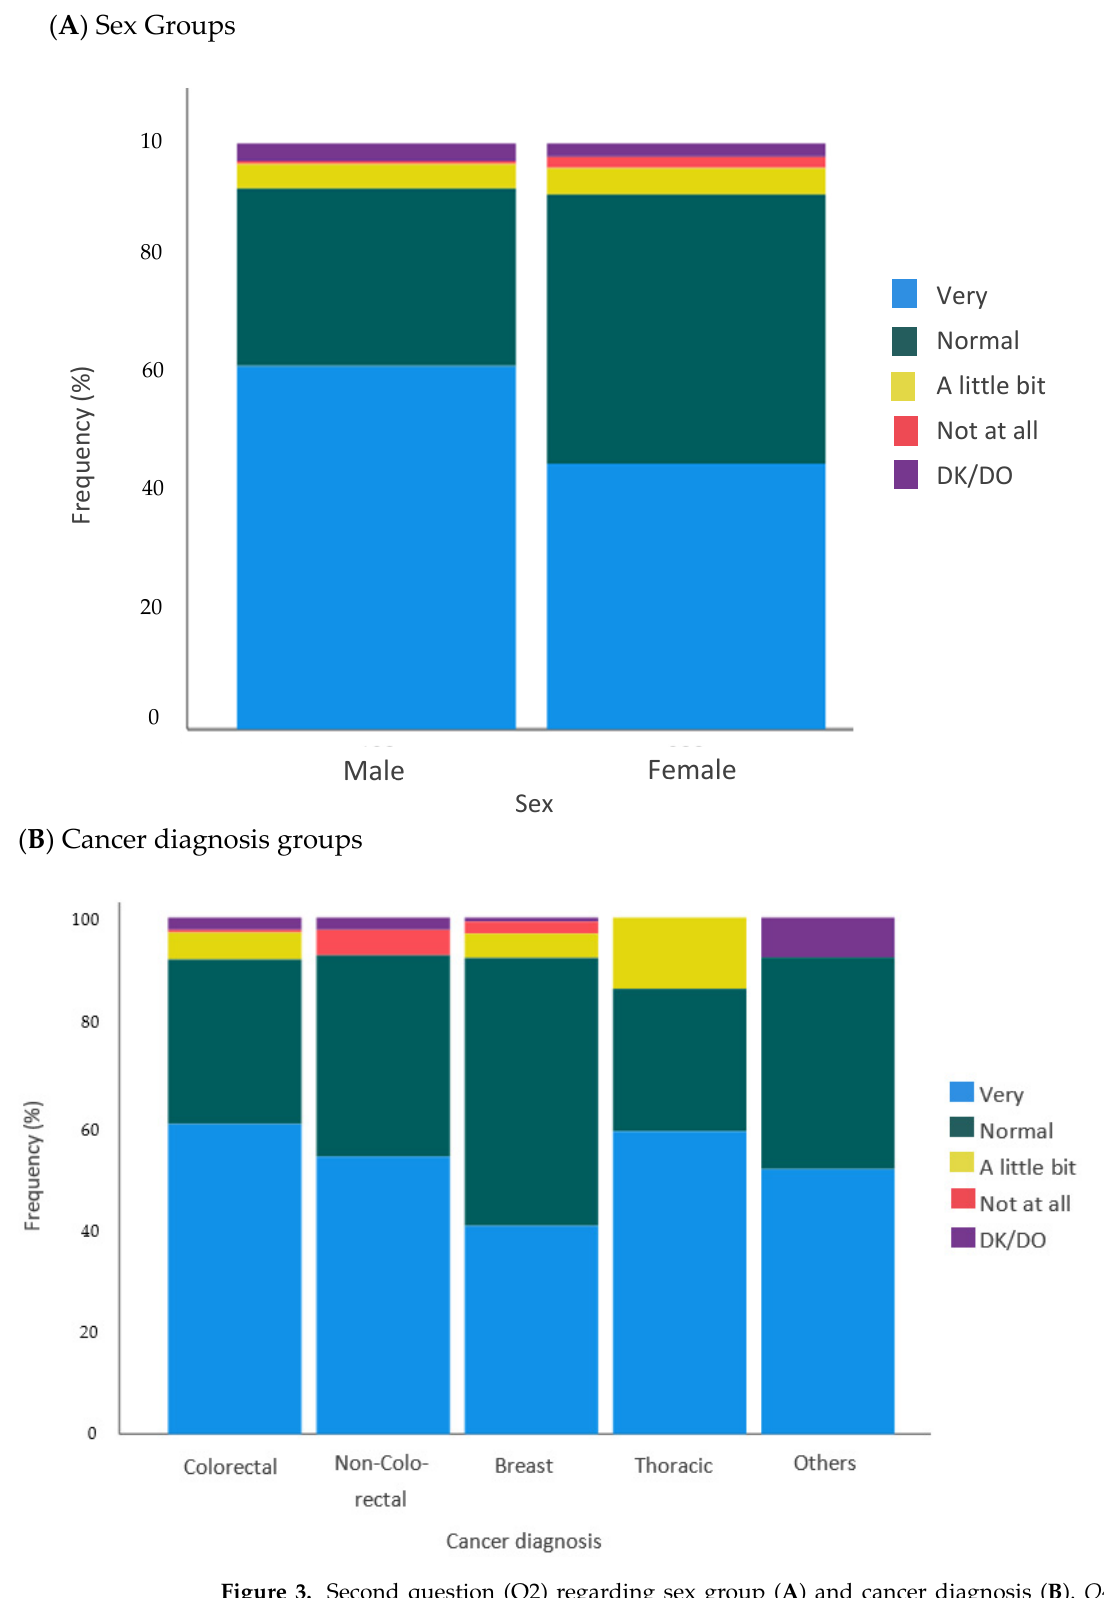
Figure 2. All patients answer to the second question (Q2). Did the oncologists’ telephone visit comfort you regarding your disease and its control?